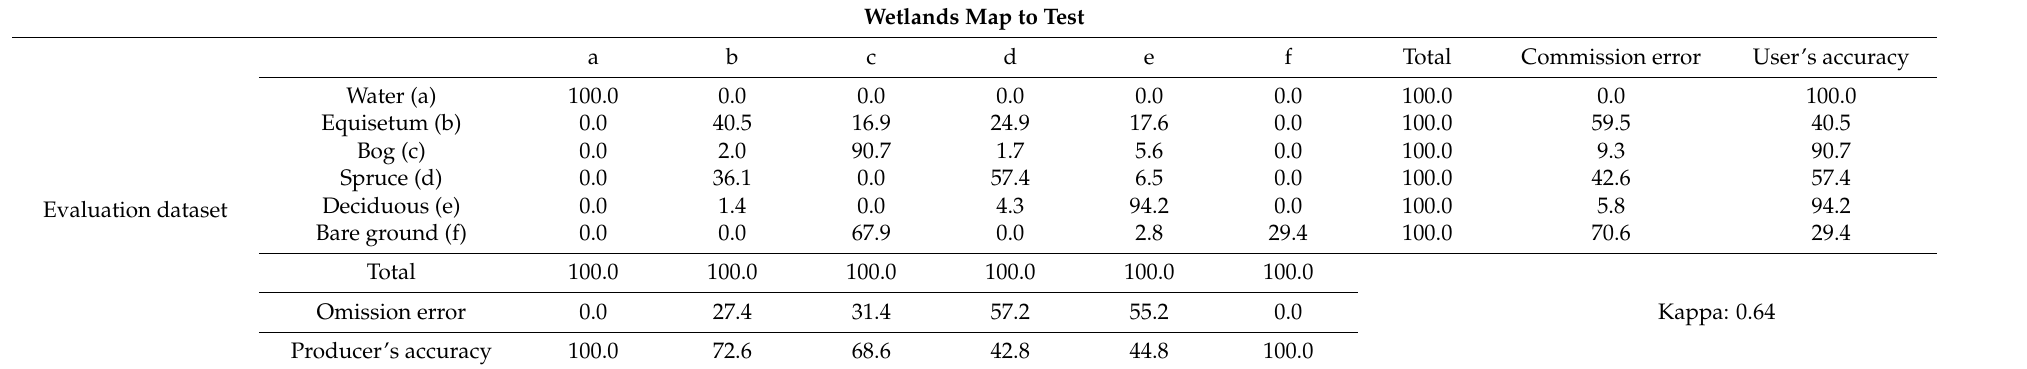
Table A3. Confusion matrix for area A SAM classification. Results in %.